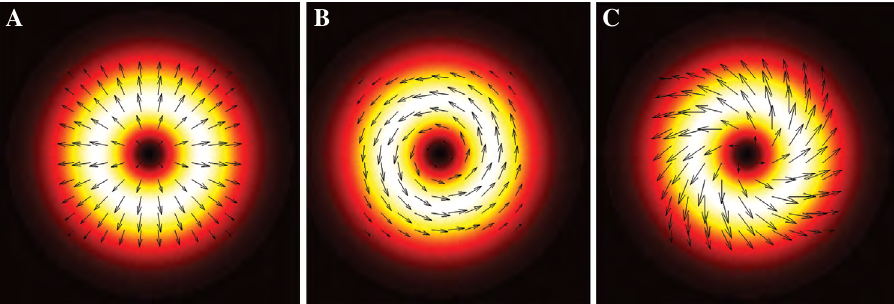
Figure 2 CV beams: (A) radially polarized